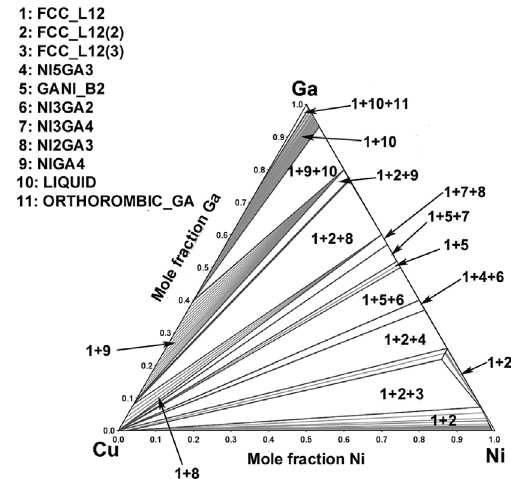
Figure 6: Calculated isothermal section of ternary Cu-Ga-Ni phase diagram at 298K (obtained using Thermocalc